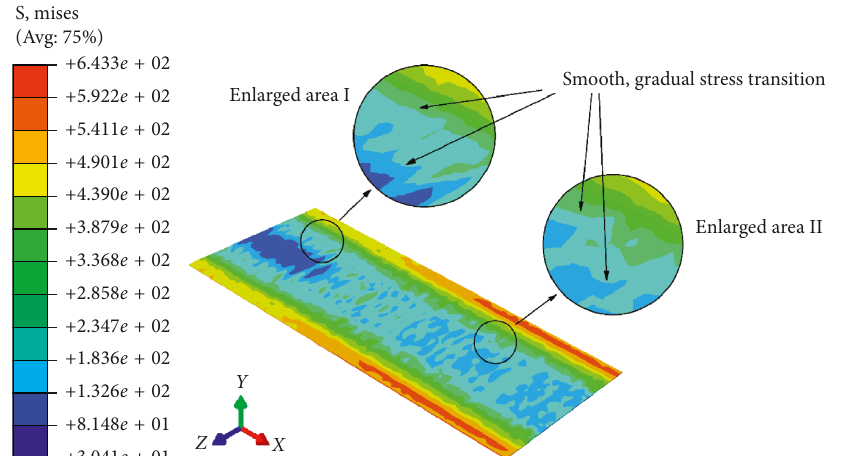
Figure 7: Distribution of effective stress in the microflexible rolled 304 stainless steel specimen S thicker thickness area with 5% reduction; enlarged area II: thinner thickness area with 10% reduction.